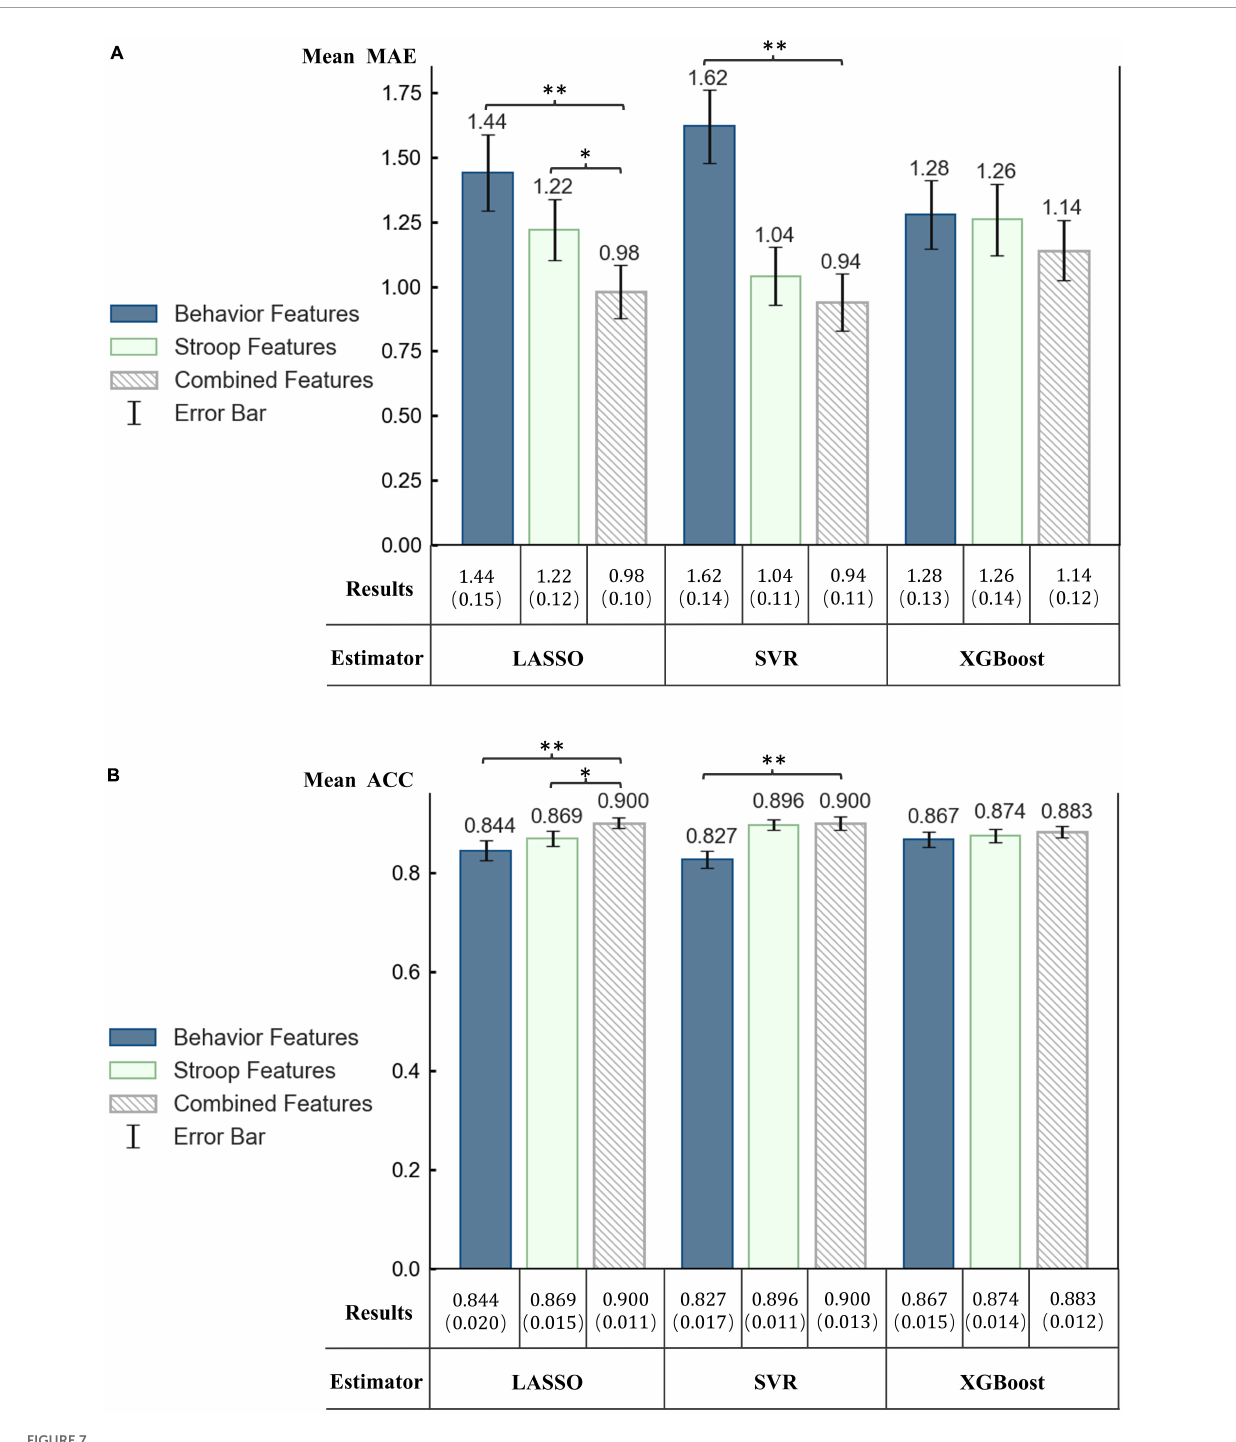
FIGURE7 Performance of regression models using different feature combinations. (A) Mean MAE and the standard error of the mean (SEM) in parentheses. (B) Mean ACC and SEM in parentheses. ∗ p 0.05. ∗∗ p